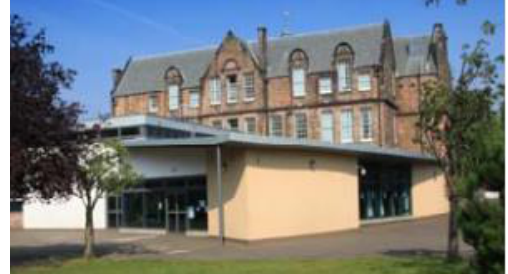
Figure 12. School D.